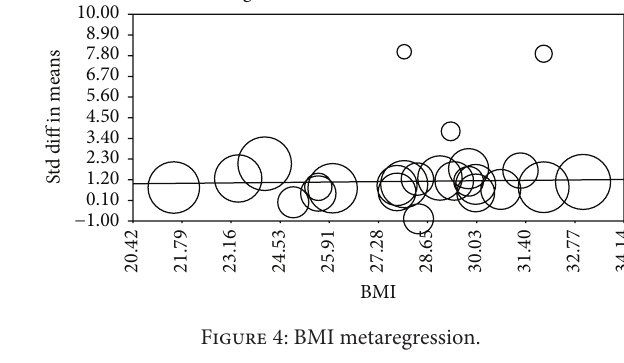
Figure 2: Age metaregression.